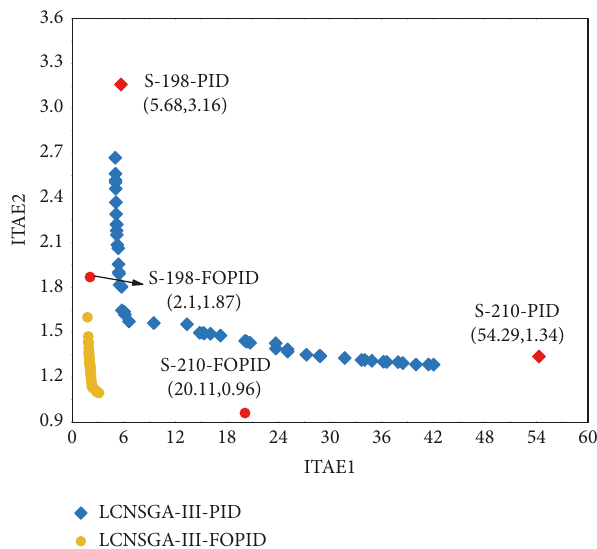
Figure 10: Pareto fronts obtained by LCNSGA-III-PID, LCNSGA-III-FOPID, and their comparison with single-objective solutions.